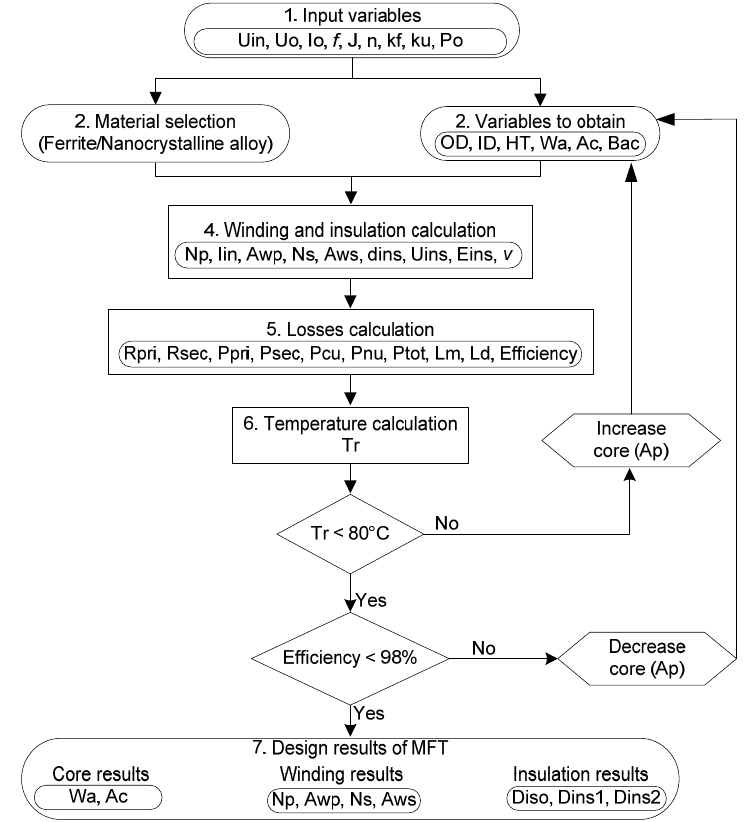
Figure 2. Design process.